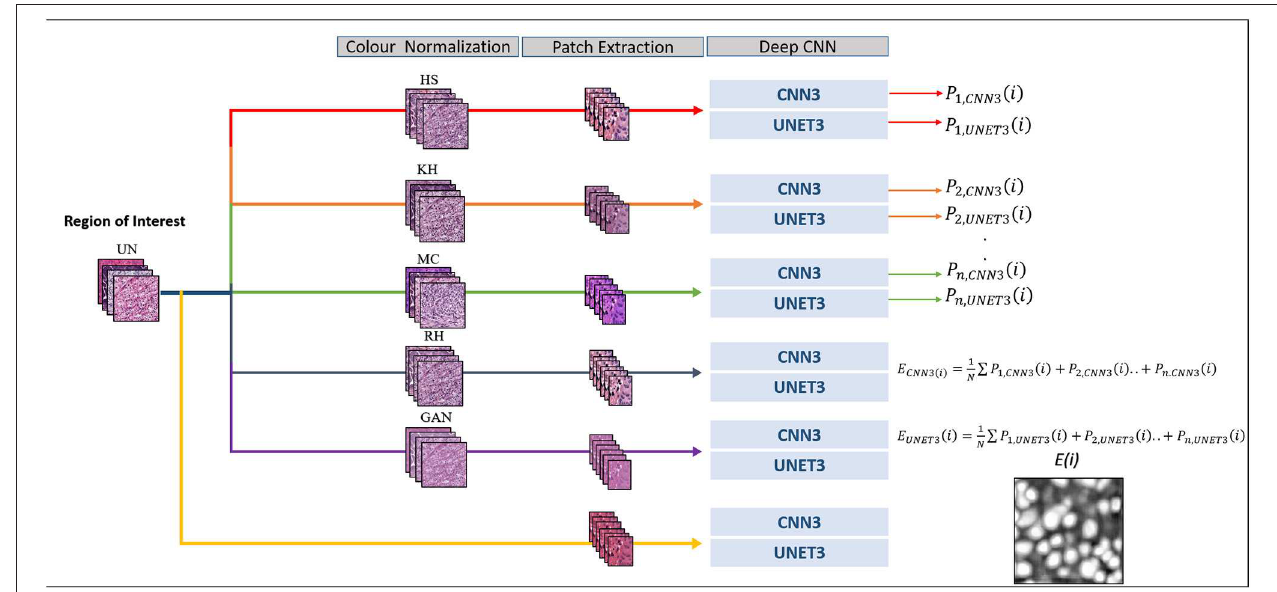
FIGURE 3 | Segmentation